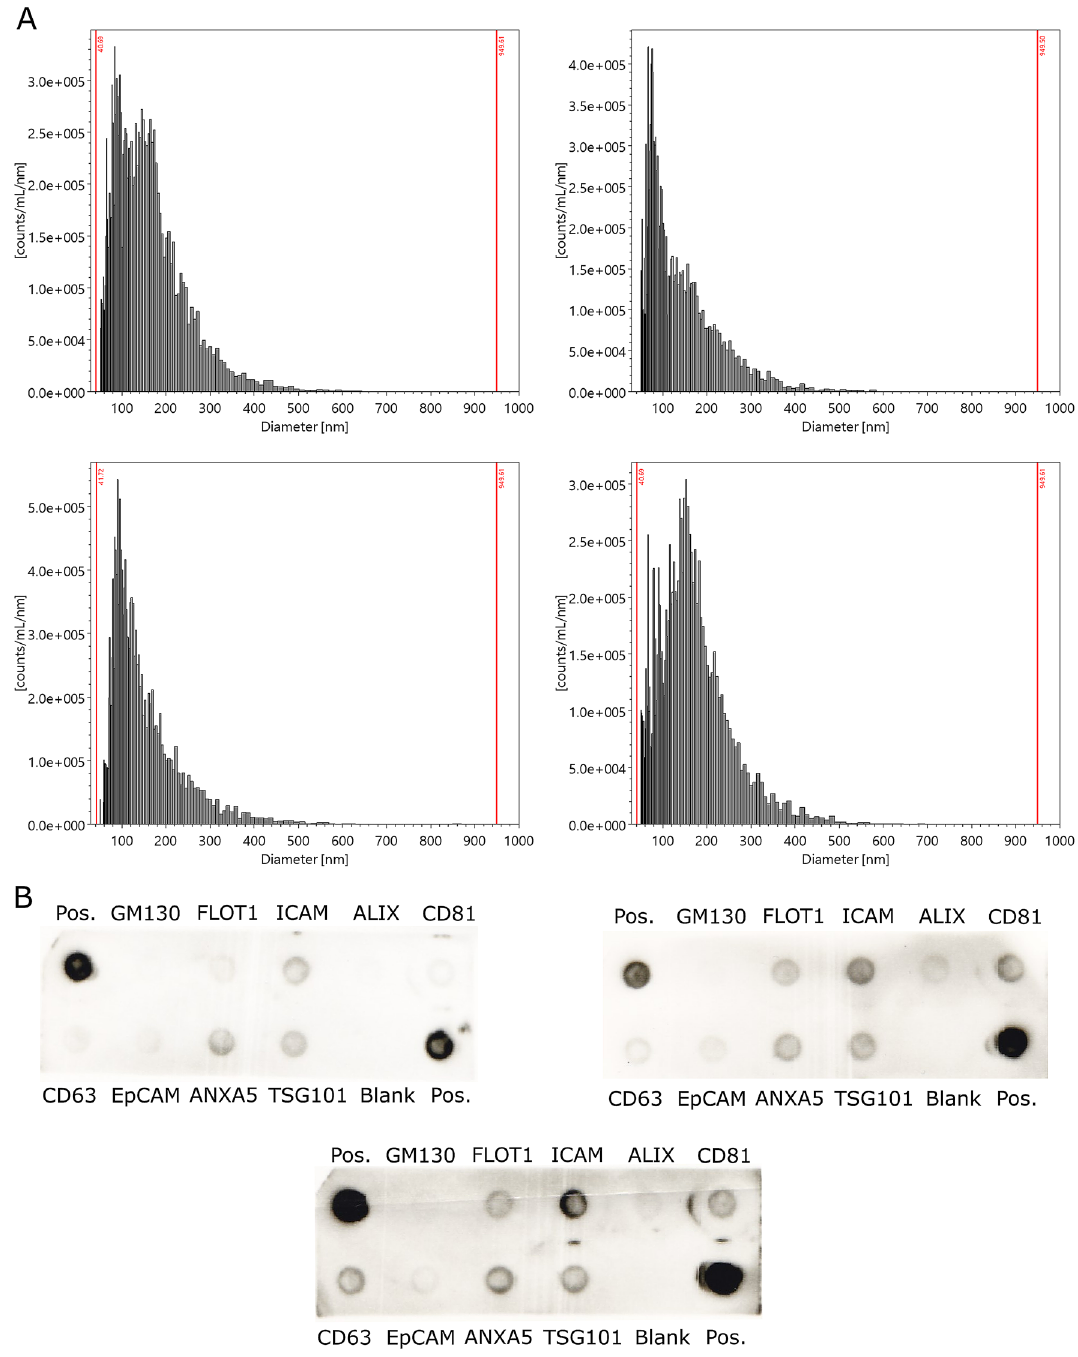
Figure 1. Characteristics of human milk EVs in representative samples. ( A ) Histograms for the number of particles per milliliter of EVs by particle diameter with bins logarithmically scaled. ( B ) Exo-Check Array results for three representative samples demonstrating exosome-related protein expression, where the darkness of the spot indicates the presence of the indicated protein. The absence of a spot for GM130 indicates absence of intracellular contaminants in the EV isolation. Abbreviations: GM130 (Cis-golgi matrix protein), FLOT1: Flotillin-1, ICAM1: Intercellular adhesion molecule 1, ALIX: Programmed cell death 6 interacting protein (PDCD6IP), CD81: Tetraspanin, CD63: Tetraspanin, EpCam: Epithelial cell adhesion molecule; ANXA5: Annexin A5, TSG101: Tumor susceptibility gene